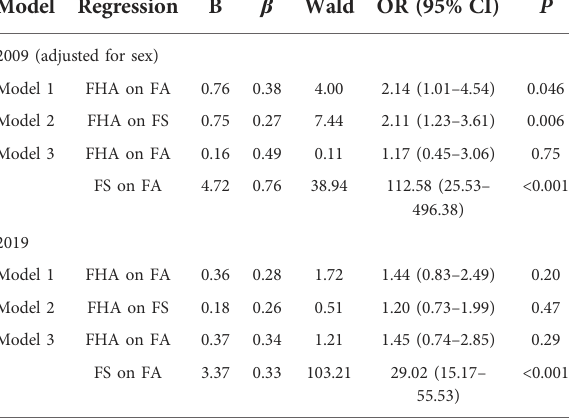
TABLE 3 Mediating effect model of FHA † , FS ‡ and FA §